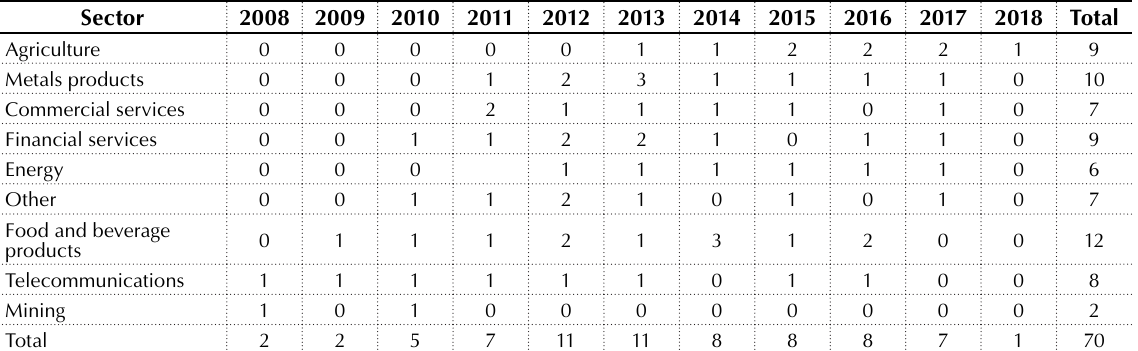
Table 1. SR in Ukraine for the period of 2008–2018 by the companies’ sector